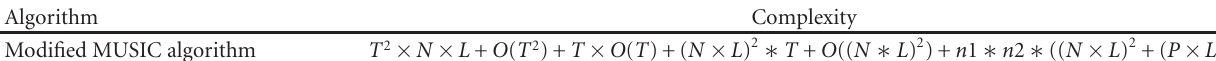
Table 1: The complexity for algorithms.